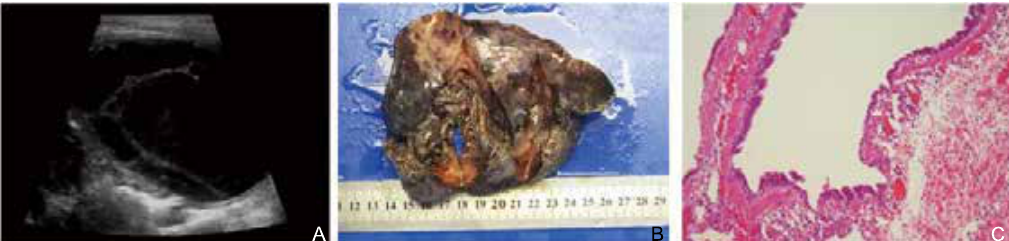
Figure.3 Ultrasonography and pathologic manifestations in type 4 CPAM: (A) A cystic mass with large cystic cavities; the largest diameter was 8 cm in diameter. The cystic wall was thickened, and there were dense, dot-like echoes in the cystic cavities. (B) Gross photo of resected specimens. (C) Microscopy showing large cyst (bronchiole like) lined by stratified columnar